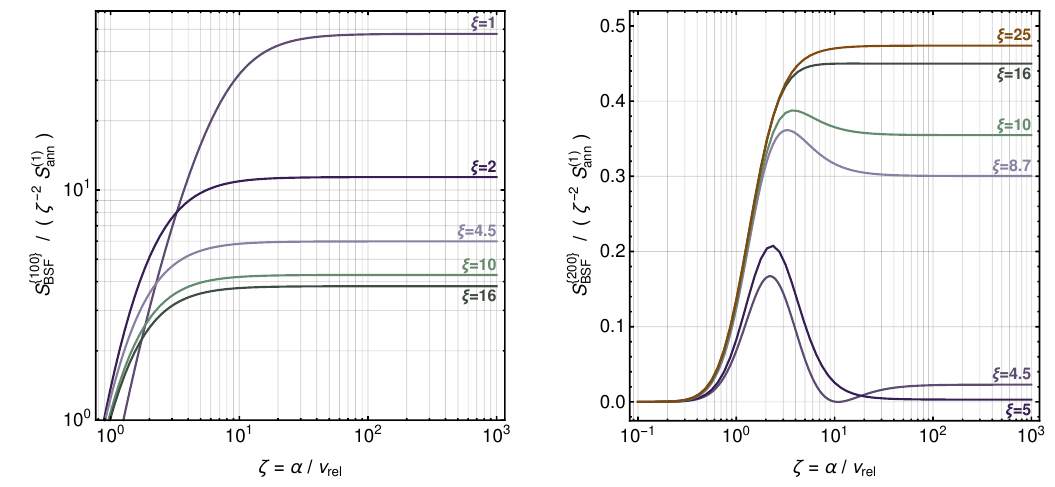
Figure 5b . Comparison of the velocity dependence of radiative capture processes with emission of a vector force mediator, to p -wave annihilation processes. The factor (cid:16) (cid:0) 2 S (1) ann captures the entire velocity dependence of the latter. At large (cid:16) , the ratio S f n 00 g = [ (cid:16) (cid:0) 2 S (1) ann ] tends to a (cid:24) -dependent BSF constant, which itself saturates to a (cid:12)xed value (its Coulomb limit) at large (cid:24) . For the ground state and (cid:12)rst excited state, S f 100 g = [ (cid:16) (cid:0) 2 S (1) ann ] ’ 2 9 = (3 e 4 ) ’ 3 : 13 and S f 200 g = [ (cid:16) (cid:0) 2 S (1) ann ] ’ 2 12 = (3 e 8 ) ’ 0 : 46 BSF BSF [cf. eq. (3.8c) and table 3].